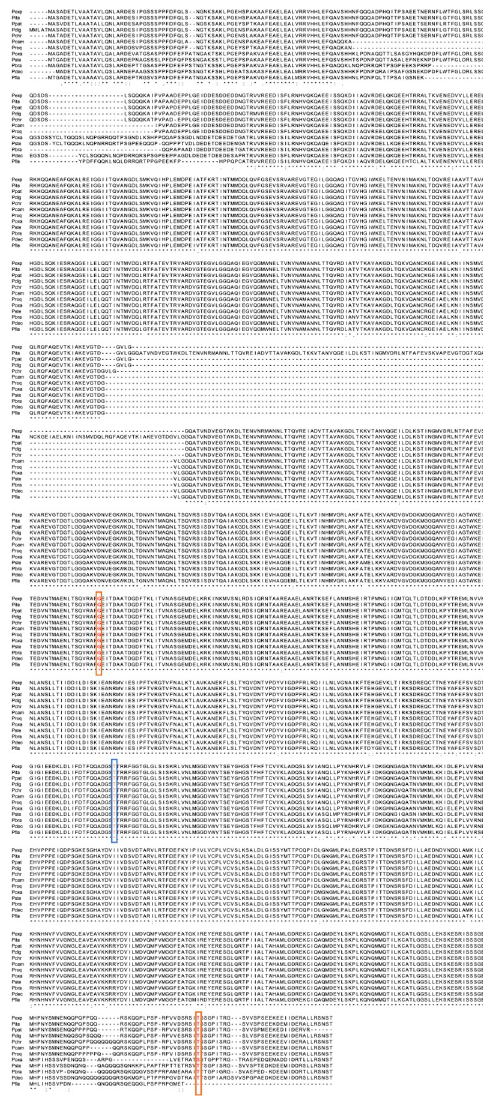
Fig 5. Sequence alignment of NikA in 12 Penicillium species. The gene IDs are as follows: P . brasilanum PMG11_02111, P . camemberti PCAMFM013_S001g000092, P . chrysogenum EN45_023640, P .